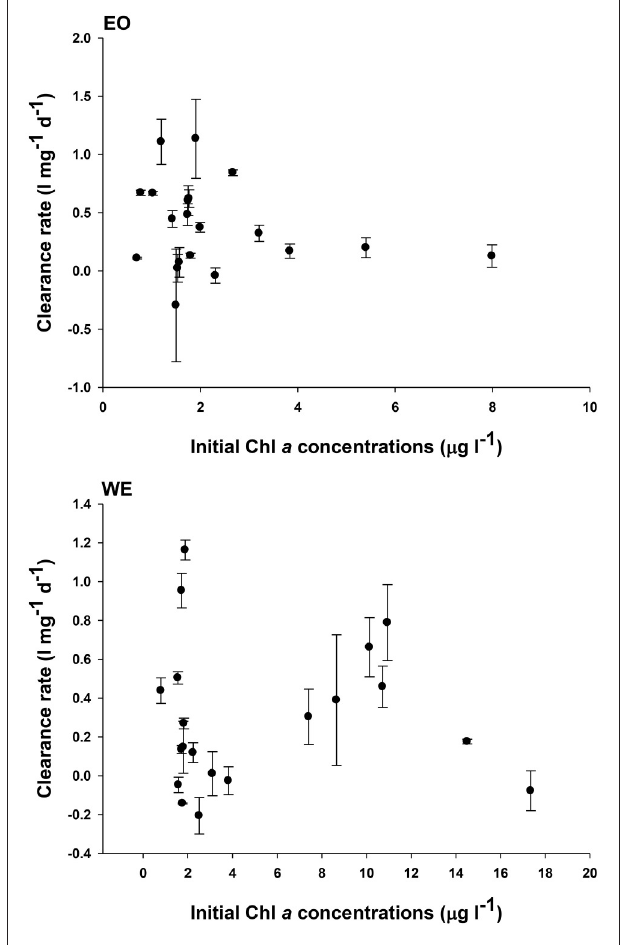
FIGURE 9 | Relationship between mesozooplankton clearance rates and phytoplankton Chl a concentrations in the two stations of Hong Kong waters: EO and